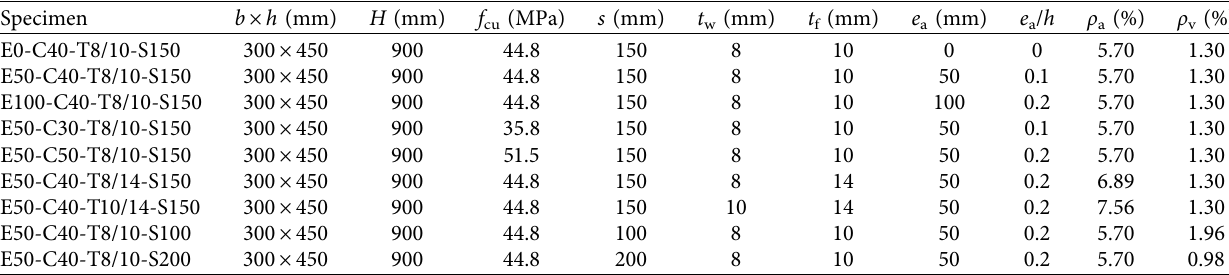
Figure 2: Schematic diagram of specimens: (a) cross section, (b) schematic view, and (c) photograph. Table 1: Test